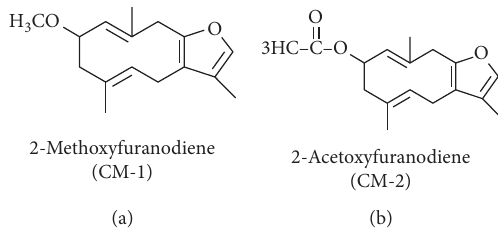
Figure 1: Structures of the two furanosesquiterpenes compounds. (a) 2-Methoxyfuranodiene (CM-1). (b) 2-Acetoxyfuranodiene